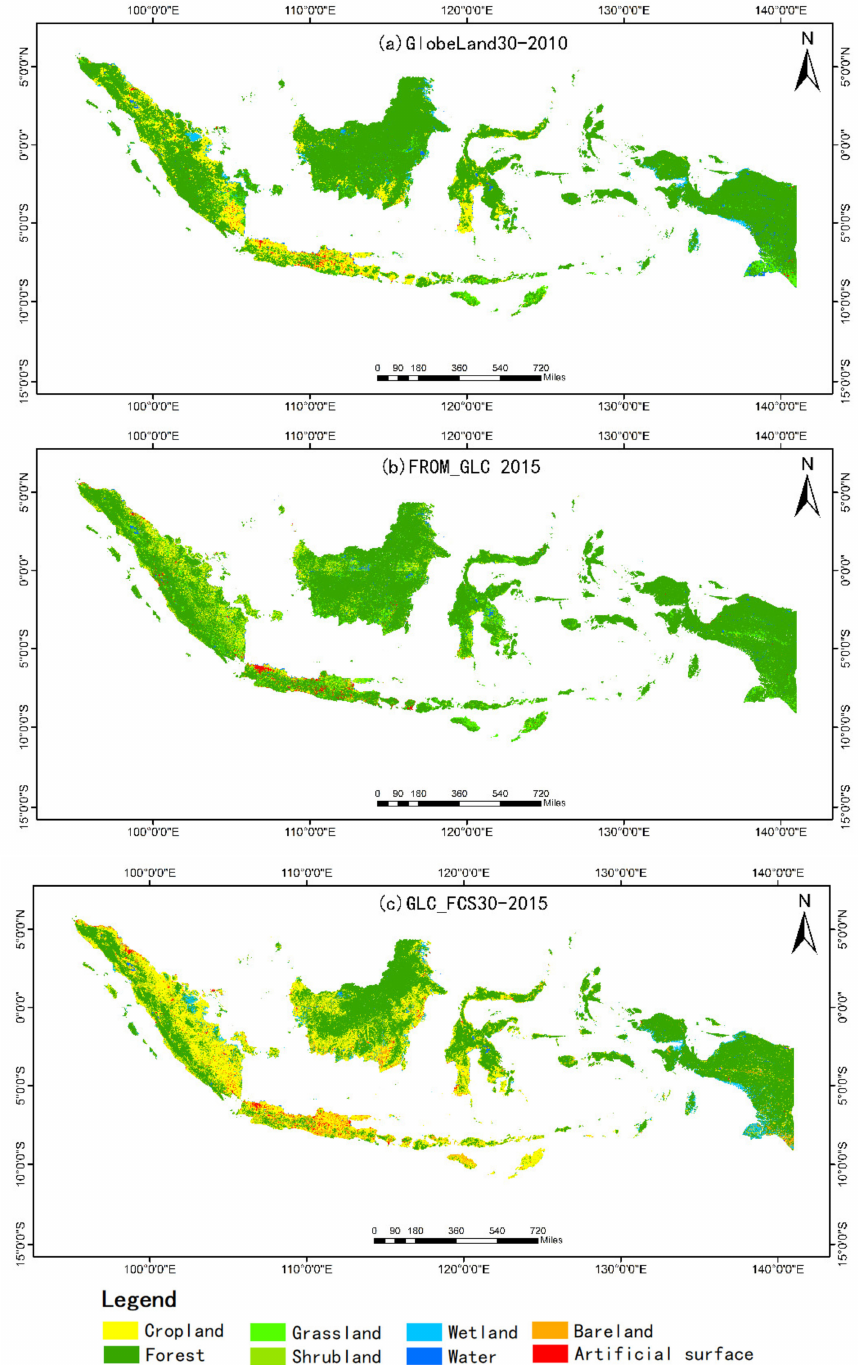
Figure 2. Spatial distributions of the three land cover products in Indonesia: ( a ) GlobeLand30-2010, ( b ) FROM_GLC 2015, and ( c )